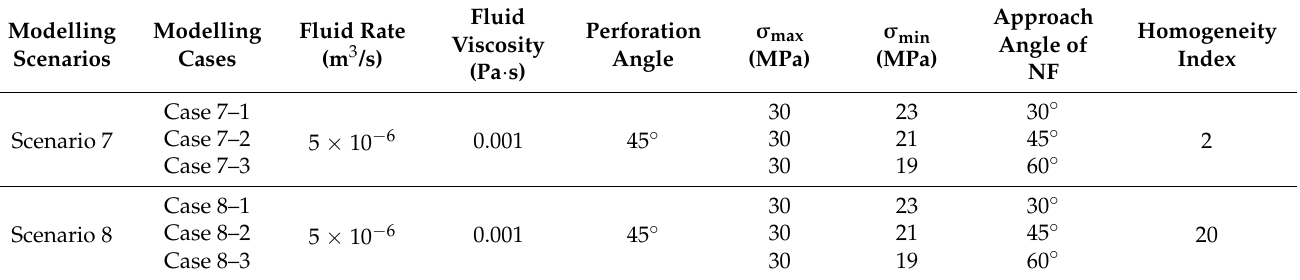
Table 9. Modelling scenarios to study the effect of NF on HF re-orientation in heterogeneous